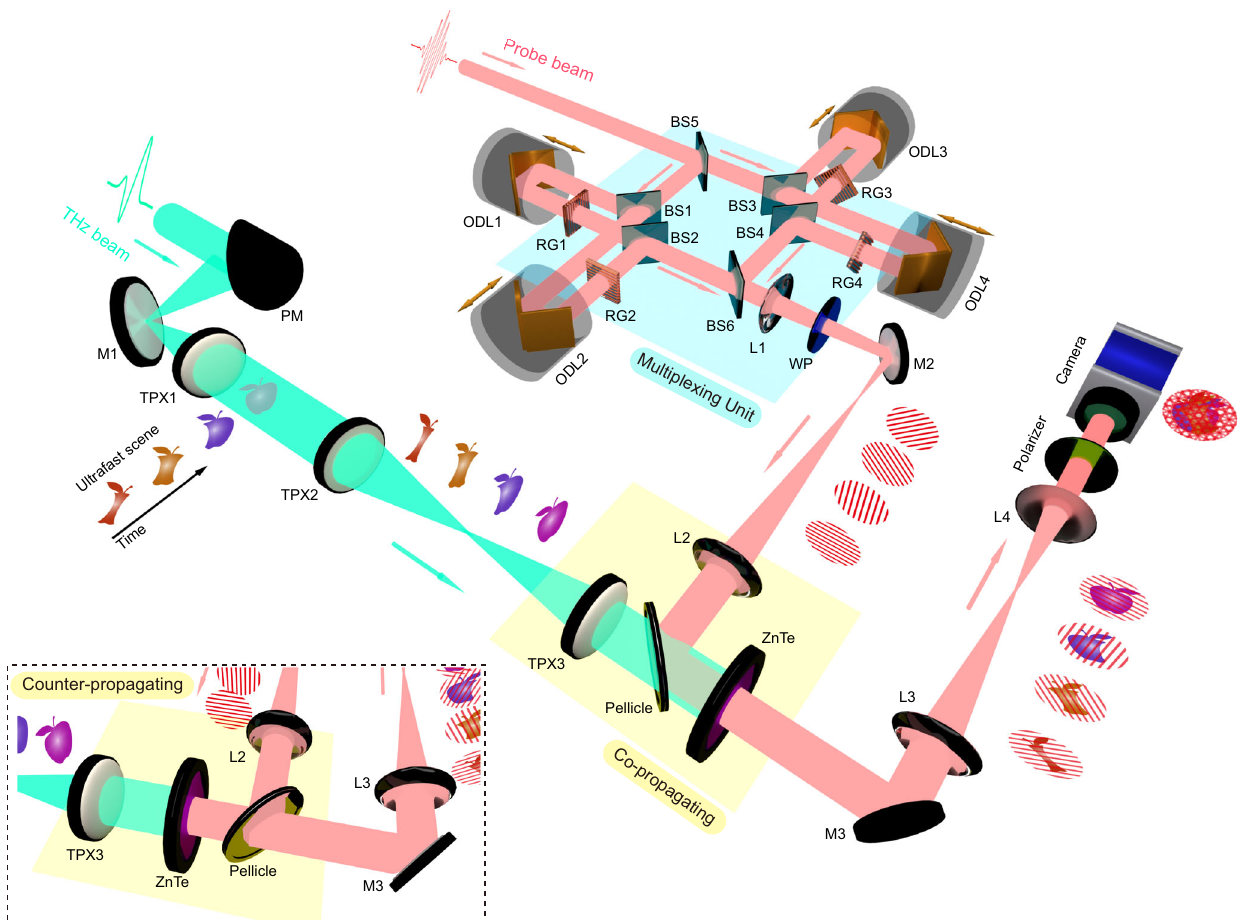
Fig. 2 | Schematics of the proposed single-shot ultrafast THz photography system. Details about the experimental setup are introduced in the Method sec- tion. The EOS technique can be operated in either a co-propagating or counter- propagatingcon fi guration,dependingonthespeci fi cexperimentrequirements.In the counter-propagating con fi guration (see inset), the multiplexed probe beam is sent to the rear of the ZnTe crystal, traveling in the opposite direction to the THz